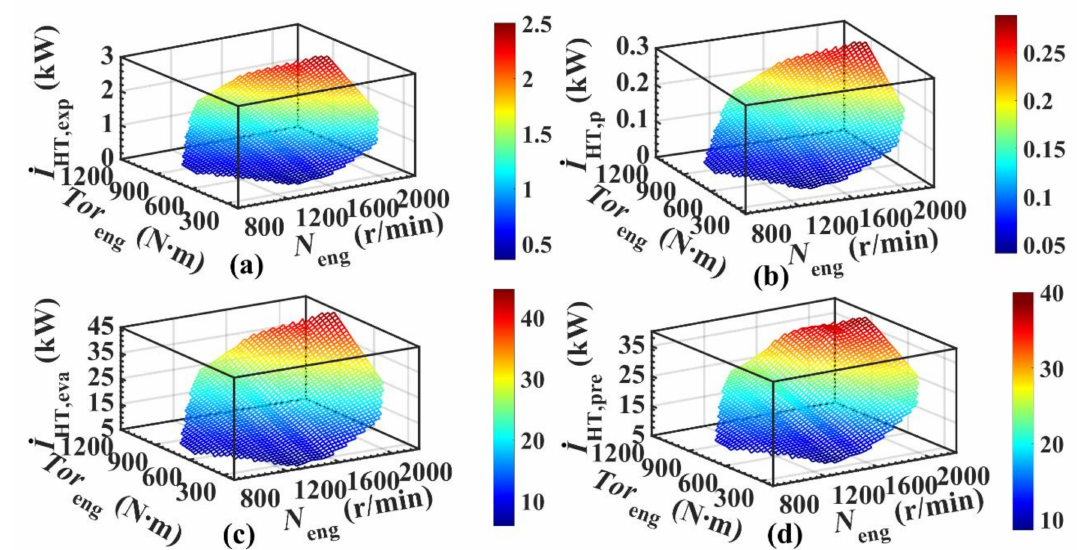
Figure 12. Dynamic response characteristics of exergy destruction of key components in HT loop under full operating conditions. ( a ) dynamic response characteristics of the exergy destruction of the expander in HT loop. ( b ) dynamic response characteristics of the exergy destruction of the working fluid pump in HT loop. ( c ) dynamic response characteristics of the evaporator exergy destruction in HT loop. ( d ) dynamic response characteristics of the preheater exergy destruction in HT